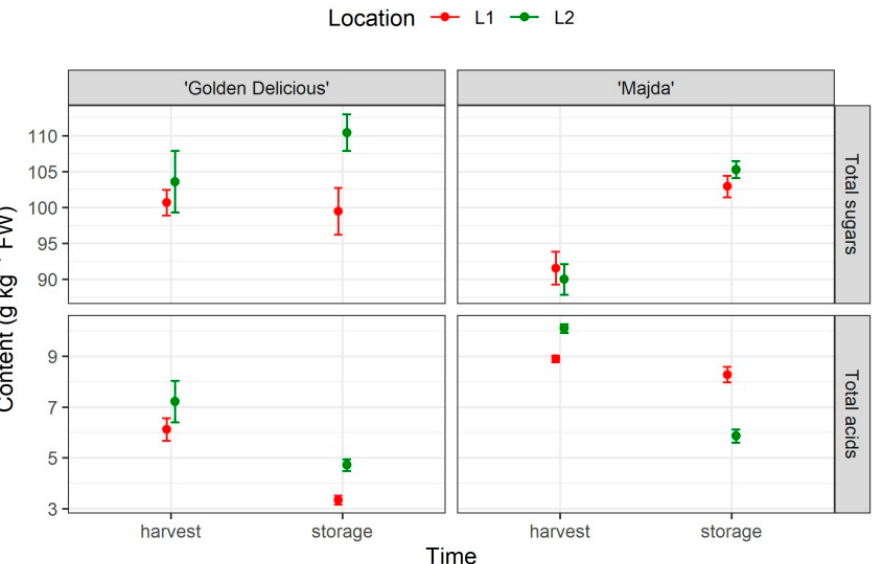
Figure 2. Content of total sugars (g kg − 1 FW; mean ± SE) and total organic acids (g kg − 1 FW; mean ± SE) of cultivars ‘Golden Delicious’ and ‘Majda’ at two locations (L1 and L2) at harvest and following storage.